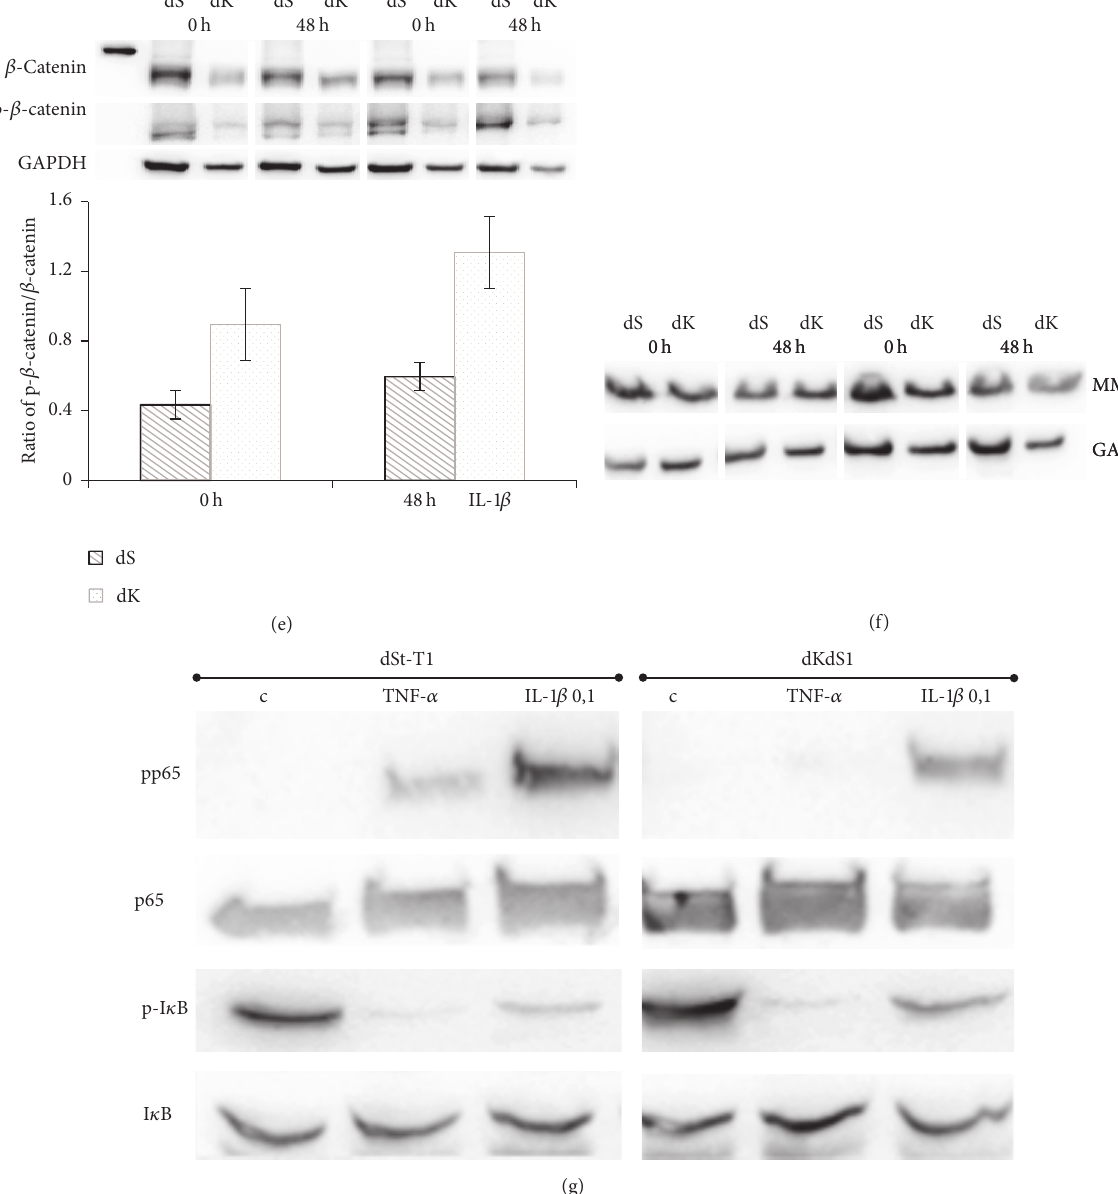
Figure 5: Western blot protein expression analysis of FZD4 (60 kDa), FZD6 (75kDa), phospho- (86kDa) and holo- 𝛽 -catenin (96kDa), and MMP7 (28kDa) in decidualized St-T1 and KdS1. (a) shows the protein expressions of FZD4 in dSt-T1 and (b) in dKdS1, (c) of FZD6 in dSt-T1 and (d) in dKdS1, (e) of 𝛽 -catenin and phospho- 𝛽 -catenin, and (f) of MMP7 and (g) NF 𝜅 B signaling after incubation with 0.1 ng/mL IL-1 𝛽 for 0 and 48 h in representative western blot analysis and the corresponding pixel density evaluation (omitted for MMP7, p65, and I 𝜅 B; TNF 𝛼 was used as control for NF 𝜅 B activity). Data represents means ± SD with ∗ 𝑝 < 0.05 for IL-1 𝛽 treated cells versus untreated cells. 𝛽 -Actin analysis served as